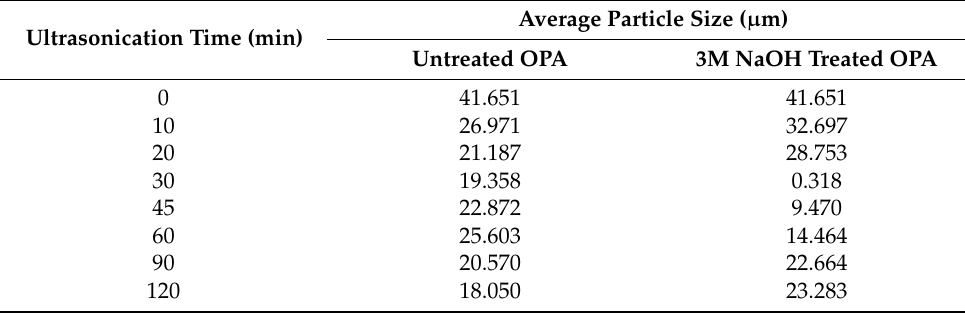
Figure 2. Change in particle size of untreated OPA suspension after different ultrasonication times: ( a ) particle size distribution and ( b ) the maximum particle size, average particle size and minimum particle size of untreated OPA. Table 4. Average particle size of OPA before and after chemical